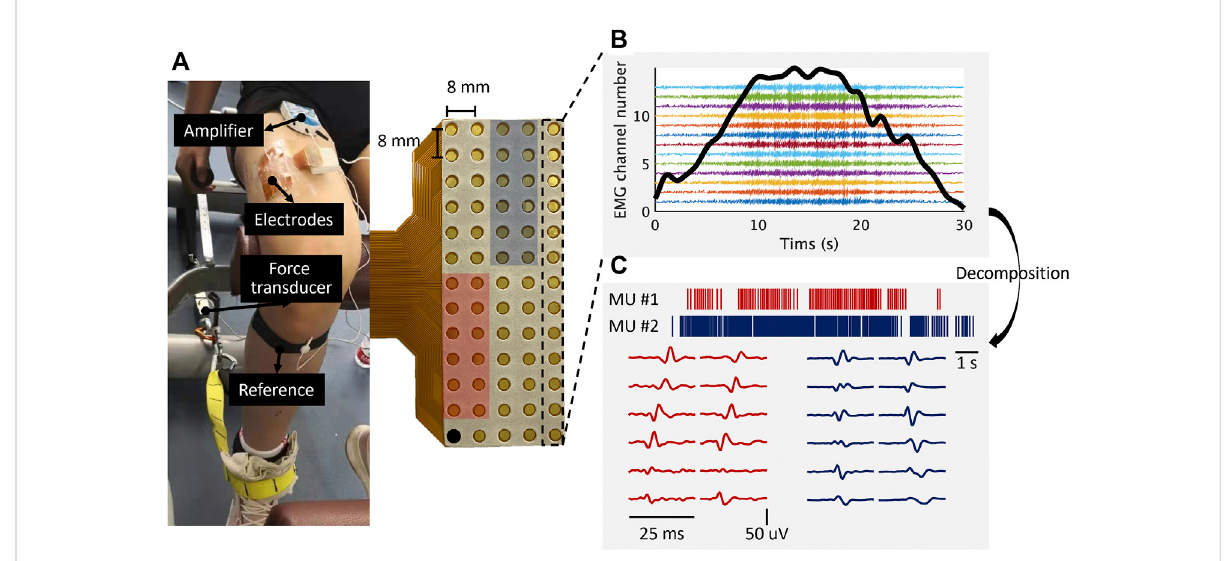
FIGURE 1 Experimental setup overview and EMG decomposition. (A) , a high-density electrode grid placed over the lateralis vastus muscles. (B) , the EMG signals from acolumnofthe grid(13channels).The bold black curveillustratestheforce signal. The location of theEMG channels is indicated bythe blackrectangle. (C) ,tworepresentativeMUspiketrainsandtheirmulti-channelactionpotentials.Thelocationoftheactionpotentialsisindicatedby the red and blue blocks,